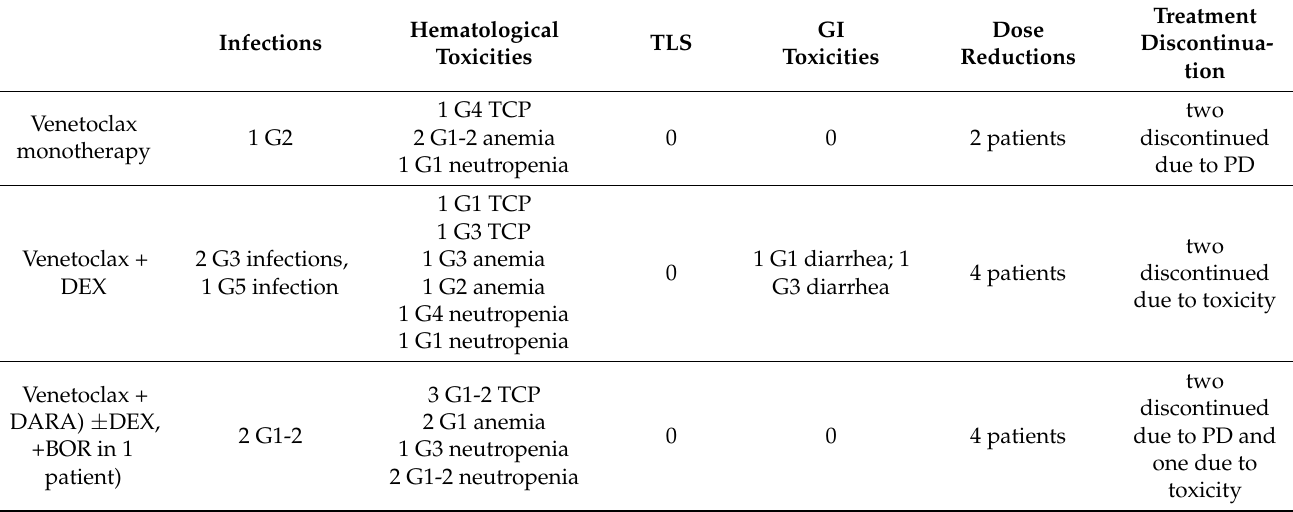
Table 3. Toxicities during venetoclax